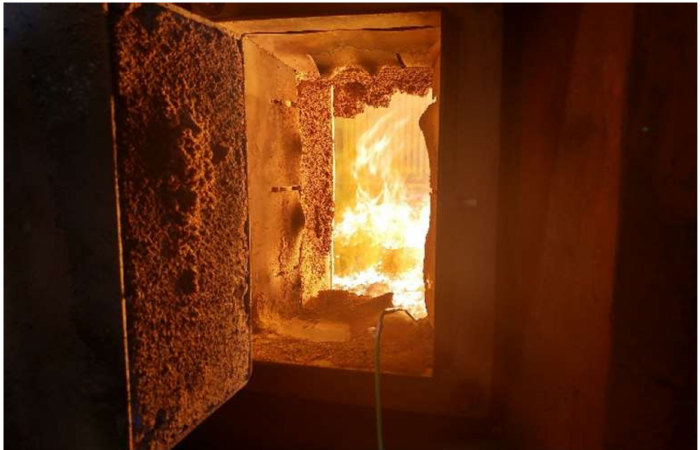
Figure 4. The middle part of grate—view from the middle inspection door of the